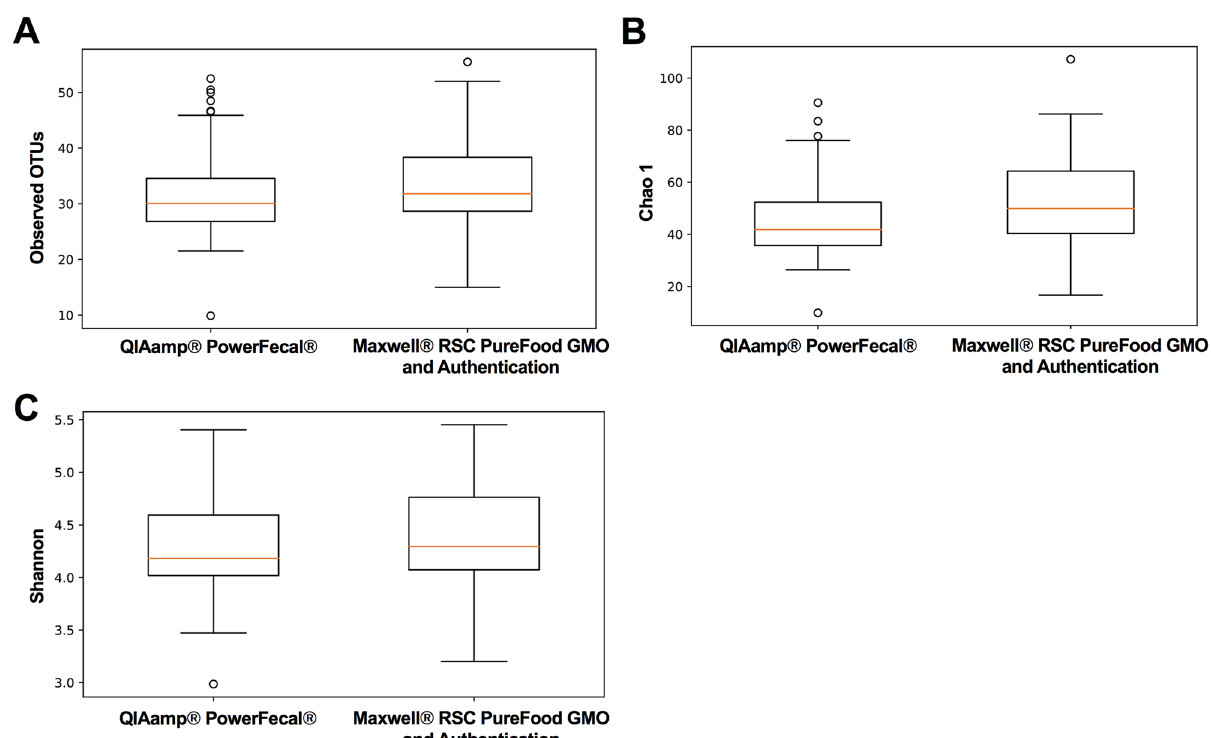
Fig 4. Alpha diversity metrics compared across DNA extraction methods. (A) Box plot comparing number of observed operational taxonomic units (OTUs) across kits. (B) Box plot of Chao1 diversity estimates for the microbial communities in DNA extracted with both the QIAamp 1 PowerFecal 1 Kit and the Maxwell 1 RSC PureFood GMO and Authentication Kit. (C) Box plot of Shannon diversity index comparing the evenness and abundance of species extracted with the two kits.